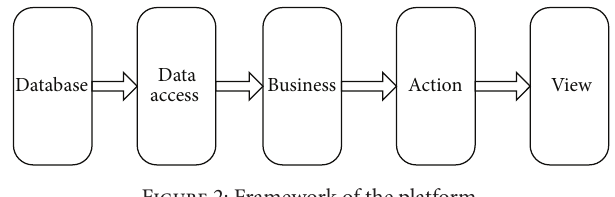
Figure 2: Framework of the